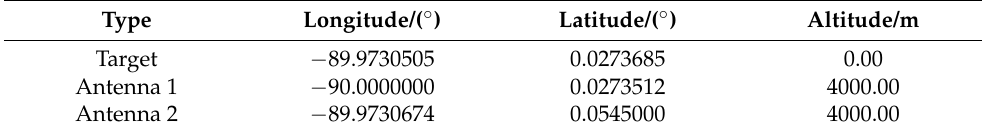
Table 3. Real positions of the target and antenna.